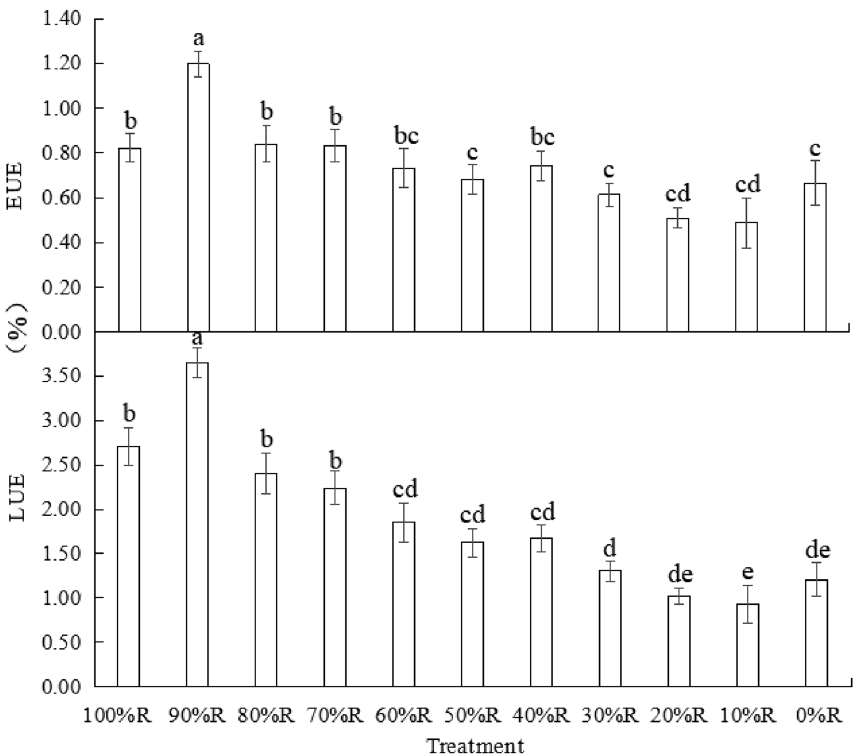
Figure 6. LUE and EUE of plants grown under different light treatments (at harvest). Different letters for the same parameter indicate significant differences at the 5% level, according to the Tukey’s test (n = 3). The bars represent the standard